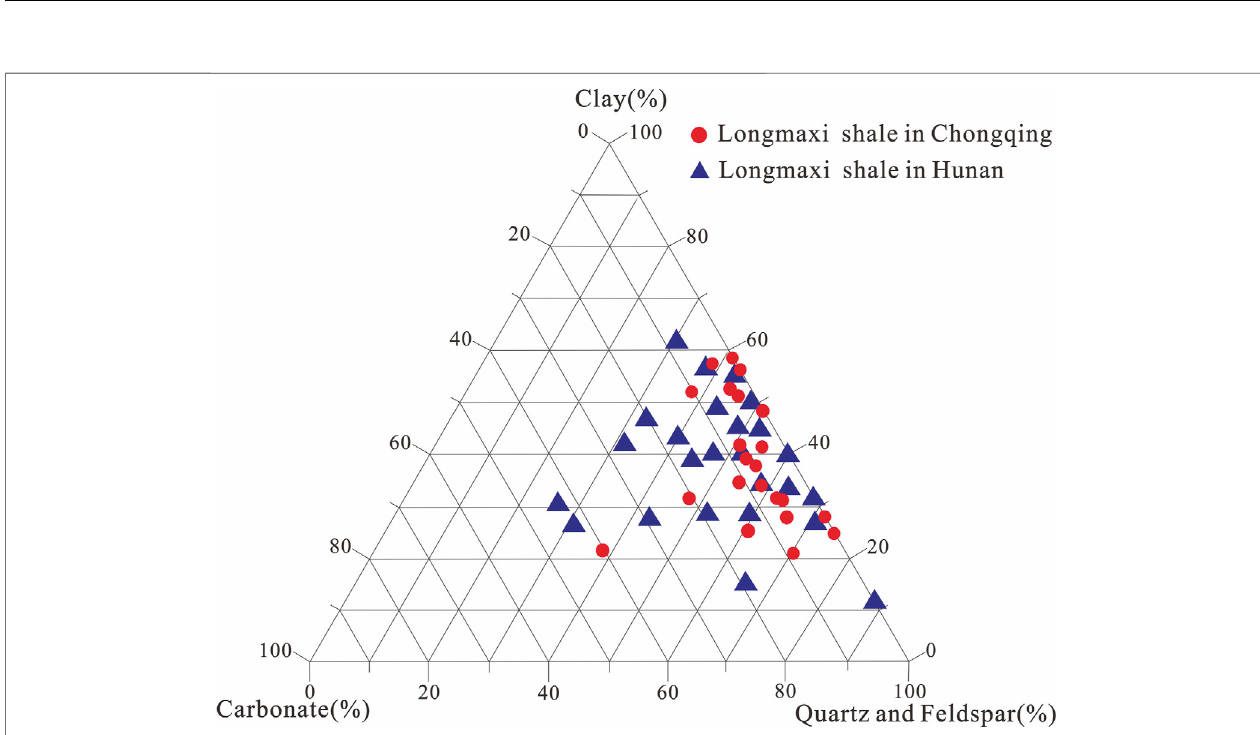
FIGURE 6 | Mineral composition from the Longmaxi shale samples in Chongqing and Hunan.